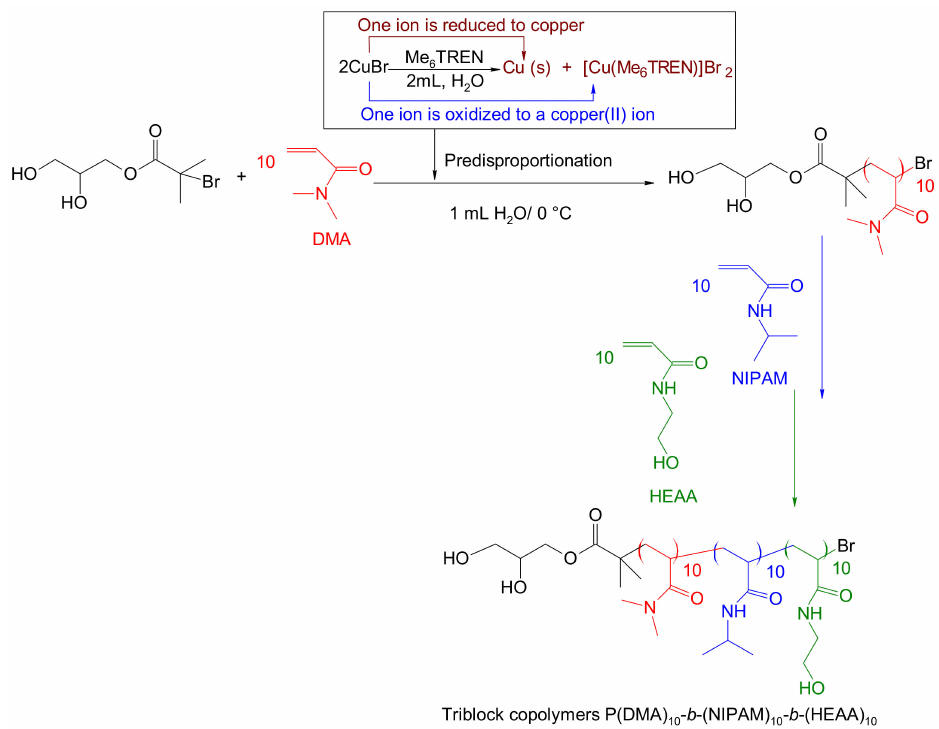
Scheme 2. Synthesis of triblock copolymers composed of DMA, NIPAM and HEAA by itera- tive Cu(0)-mediated polymerization in H 2 O at 0.0 ◦ C via prior disproportionation. Conditions: